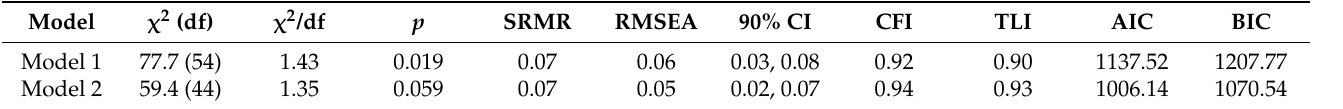
Table 5. Confirmatory factor analysis of